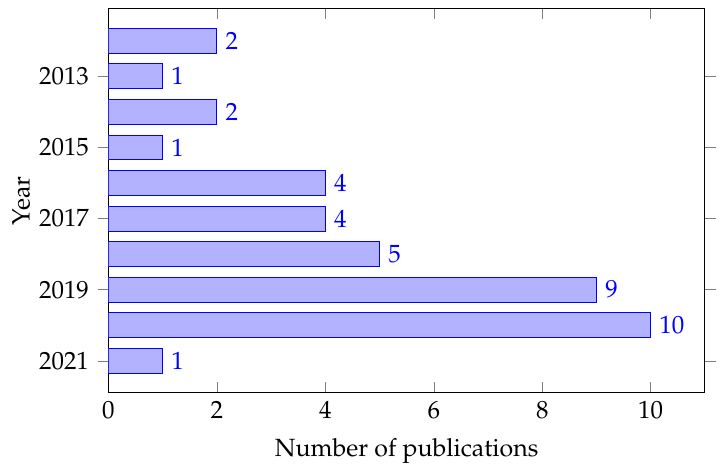
Figure 4. Publications per year about EEG signal classification during lower limbs